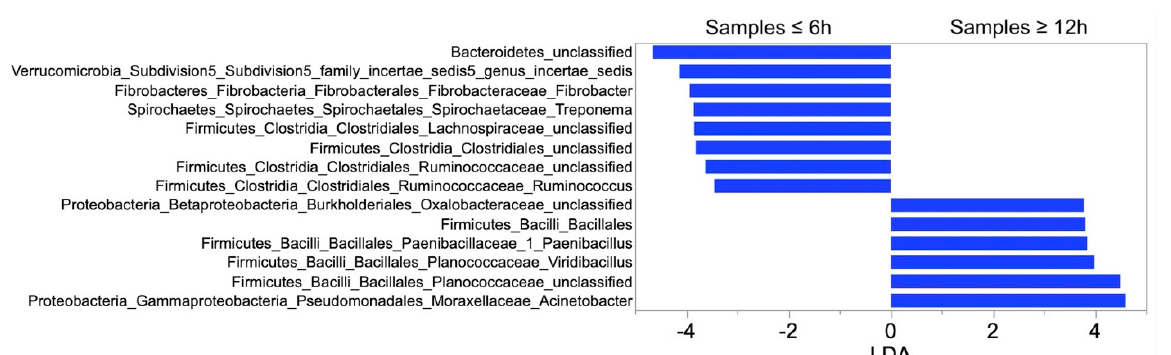
Figure 2. Linear discriminant analysis (LDA) scores of differentially enriched taxa in fecal samples stored at ambient temperature for 0 h to 6 h (left panel) and 12 h to 96 h (right panel) before freezing and sample processing.